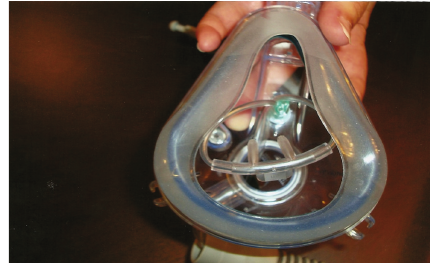
Figure 1: Dual mask is easy to apply with inner nasal cannula.